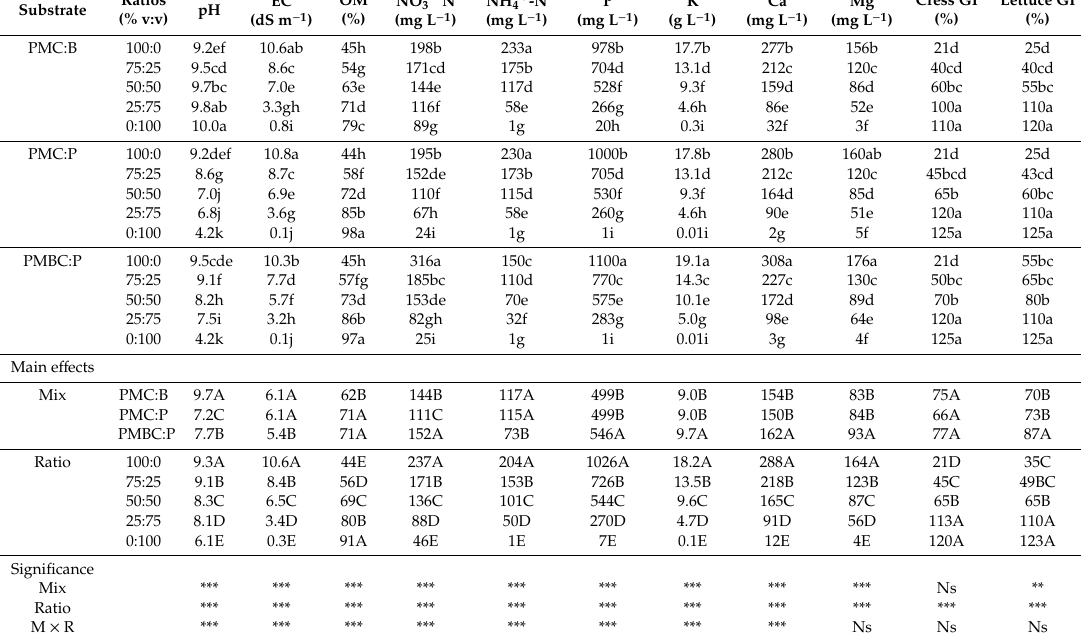
Table 3. Physico-chemical characteristics (pH and electrical conductivity, EC), total organic matter (OM), available (water extractable) nutrient content, and potential phytotoxicity measured by the cress and lettuce seed germination bioassays (germination index (GI), [40]) of growth media containing mixes of poultry manure composted without biochar (PMC), poultry manure composted with biochar (PMBC), biochar (B) and peat (P) at di ff erent ratios. Main e ff ects and statistical significance according to factorial analysis of variance. Three replicates (n = 3) were used for each substrate and ratio for all parameters with the exception of Cress GI and Lettuce GI in which five (n = 5) replicates were used.